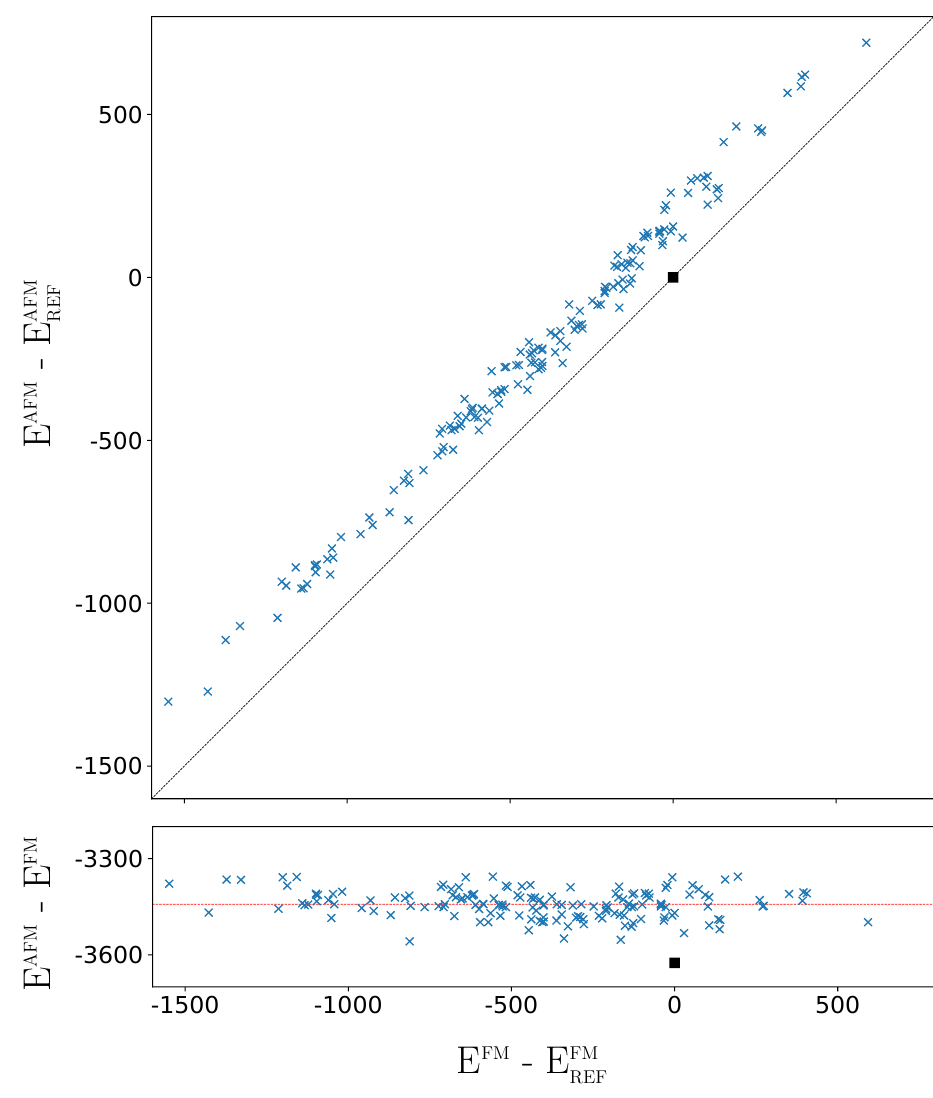
Figure 6. Difference between the AFM energy of the 162 SICs with respect to the REF case (top panel), and difference between the AFM and FM energies (bottom panel) as a function of the relative FM energy. The horizontal line corresponds to the average stabilization energy of the AFM solutions with respect to the FM ones. In both panels, energy at the B3LYP level (for 2 f.u. in µ E h ). The square indicates the REF